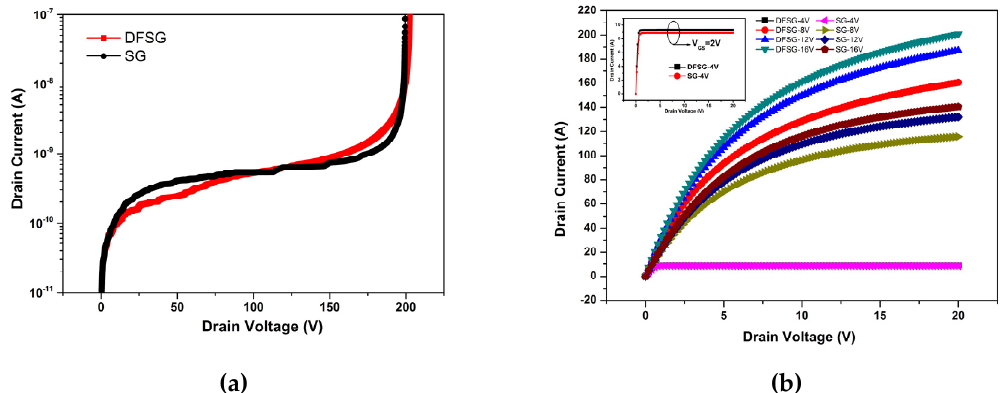
Figure 10. Characteristics comparison of ( a ) breakdown voltage and ( b ) output characteristics for the SGRSO and DFSGRSO UMOSFETs.